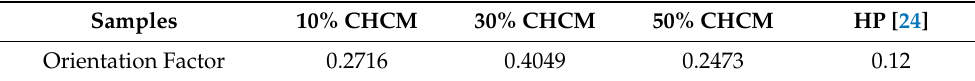
Table 1. Orientation factors of CHCM samples with different deformations and HP samples.